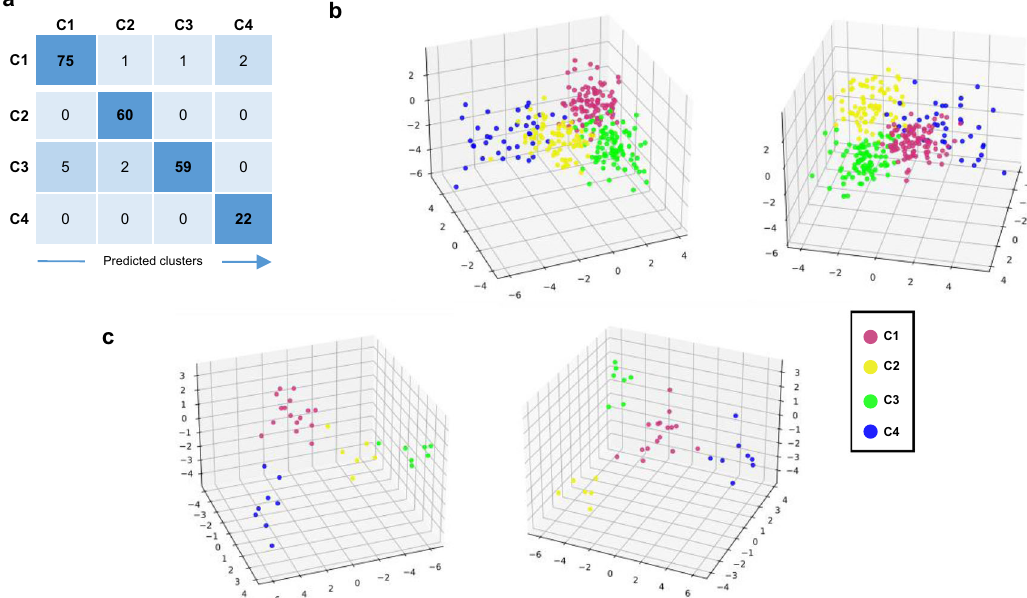
Fig. 8 Development of a composite model to predict the belonging of a patient to one of the 4 clusters. a Confusion matrix of the composite model in the discovery cohort performed for 227 pSS patients (C1: 79, C2: 60, C3: 66, and C4: 22) is shown. b Discriminant function analysis (DFA) of the predicted patients from the discovery cohort shows clearly separated clusters. Two different views of the same DFA are shown. c DFA of the predicted patients from the inception cohort shows clearly separated clusters. Two different views of the same DFA are shown. Thirty-seven pSS patients from the inception cohort were analyzed and predicted as C1: 16, C2: 6, C3: 7, and C4: